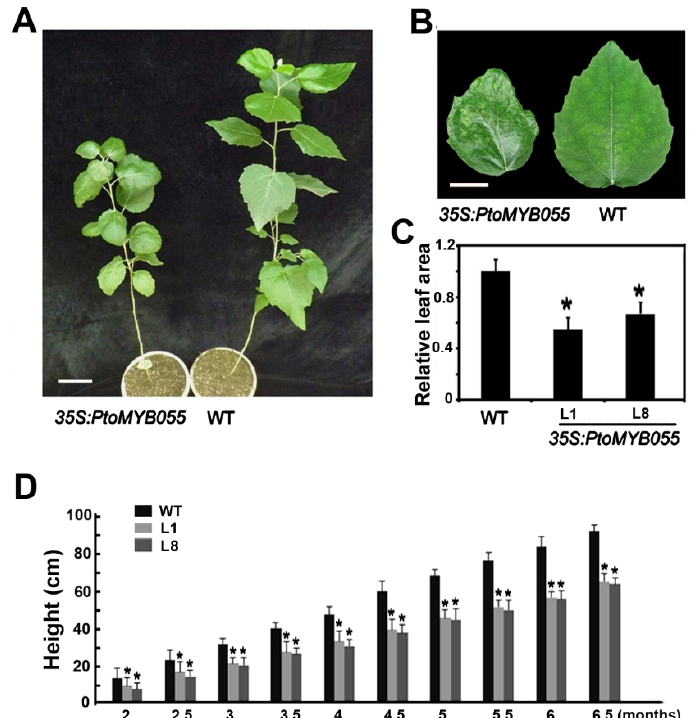
Figure 4. Phenotypes of transgenic poplar plants overexpressing PtoMYB055 . ( A ) Growth in the 35S-PtoMYB055-overexpressing poplar and the wild type. Scale bar = 10 cm. ( B ) Leaf morphology of the 35S-PtoMYB055-overexpressing poplar and the wild type. Scale bar = 5 cm. ( C ) Relative leaf area of 35S-PtoMYB055 and the wild type. * p < 0.05 ( t test). ( D ) Heights of 35S-PtoMYB055-overexpressing poplar and the wild type over time. * p < 0.05 ( t test).